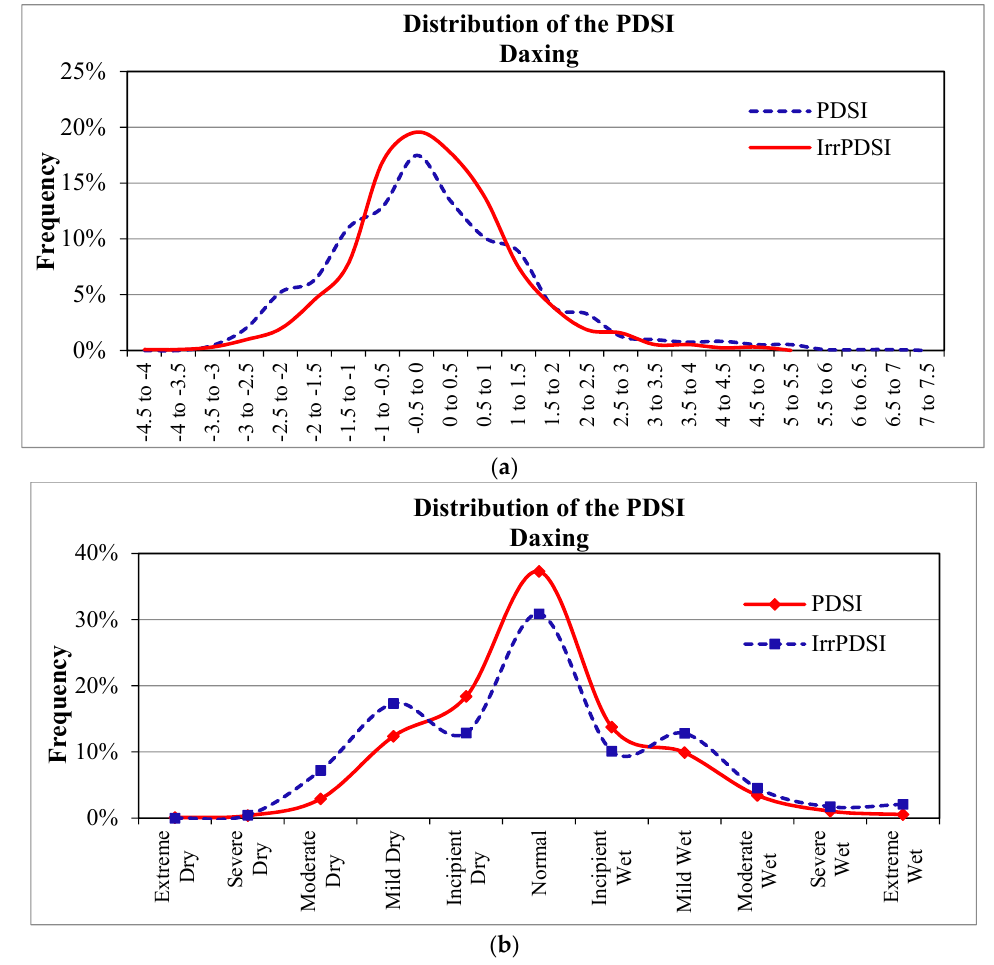
Figure 7. Plots showing the frequency of the two weekly PDSI values ( a ) over the entire range of PDSI values and ( b ) over the major PDSI categories for Daxing.